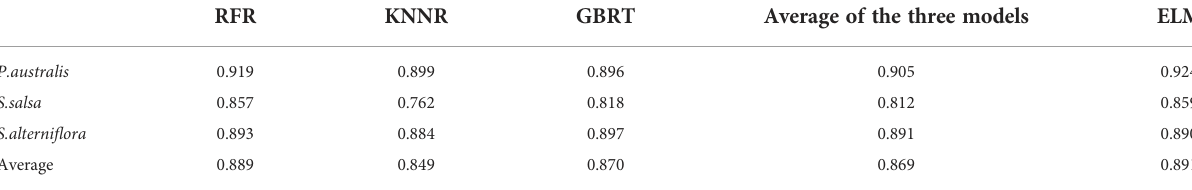
TABLE 2 R-square of the estimated fractional cover based on cloud-removed images in Scenario